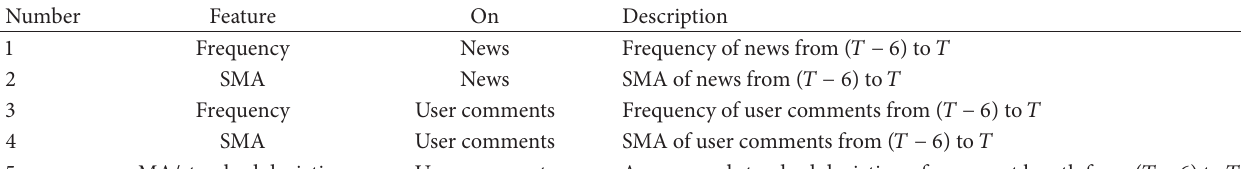
Table 7: Features from news dynamics and user comment dynamics.